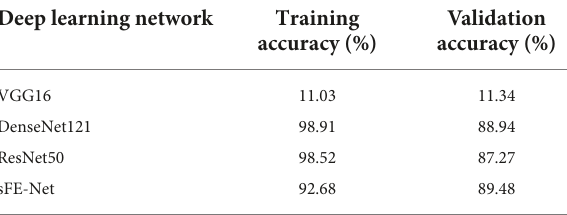
TABLE 10 Performance comparison among deep-learning